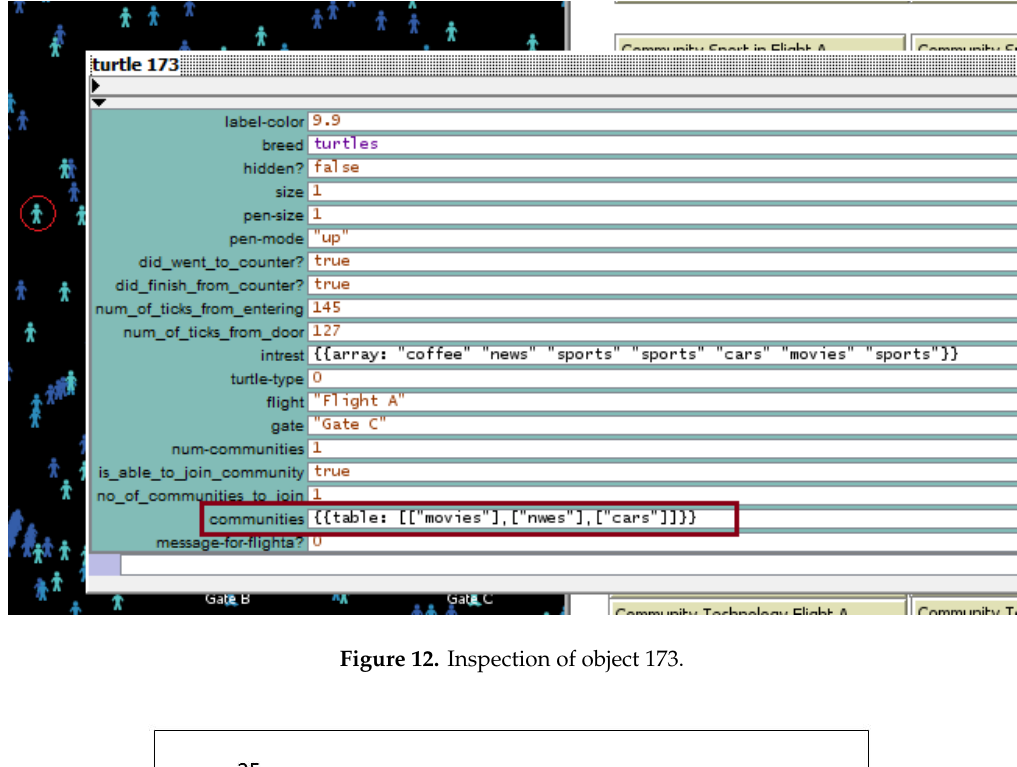
Figure 12. Inspection of object 173.